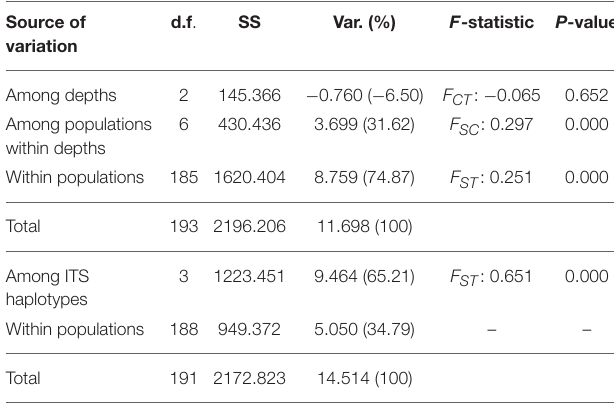
FIGURE 3 | Median-Joining haplotype networks for the host mitochondrial ORF. Size of the circles is proportional to the frequency of the haplotypes. As in Figure 2 , marks on the lines of the network indicate evolutionary steps; letters by the haplotypes correspond to the letters used in the text to refer to specific haplotypes. (A) Colors correspond to the clusters of ITS2 (see Figure 2 ), (B) colors correspond to the depth range and capital letters in the shaded areas correspond to the haplotype groups in Nakajima et al. (2017) . TABLE 2 | Analyses of molecular variance (AMOVA) of Seriatopora ORF according to depth of ITS